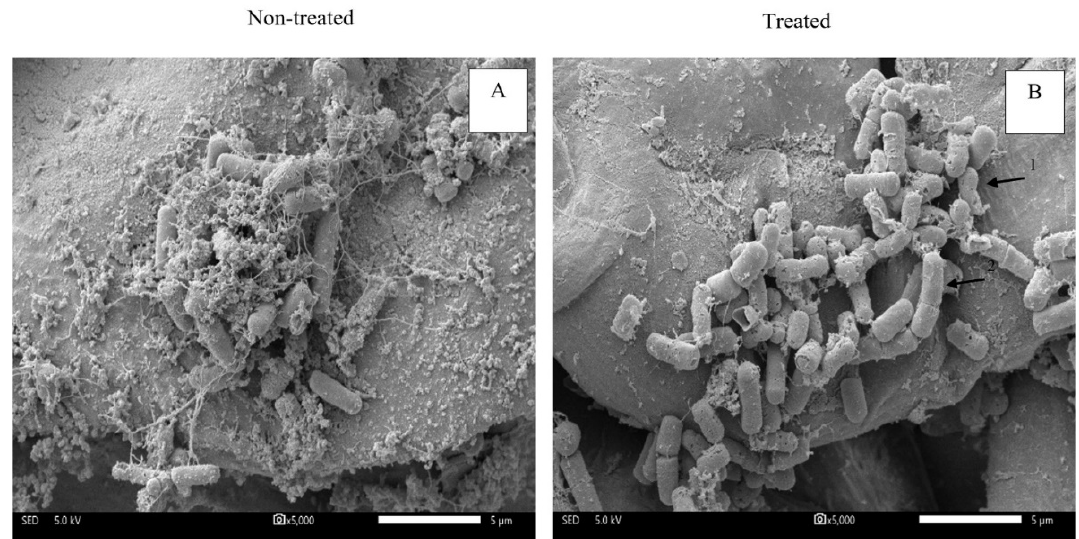
Figure 3. Scanning electron micrographs of B. cereus on coconut husk at 5000 × magnification; non- treated ( A ) and treated with 15:20% ( w/v ) salt/acid solution for 10 min ( B ), respectively. Cell twisted (arrow #1) and cell elongated (arrow #2).